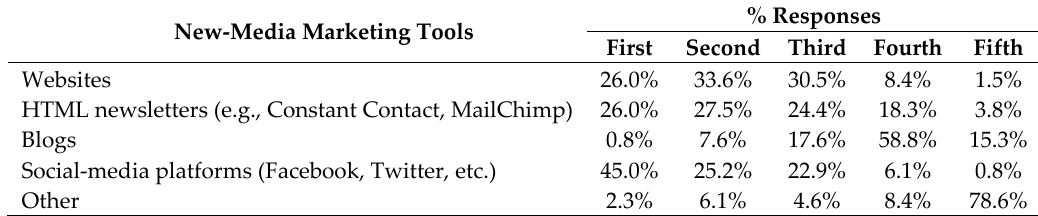
Table 6. Ranking of perceived impacts on sales of ornamental horticulture industry respondents in the study questionnaire ( n = 131).